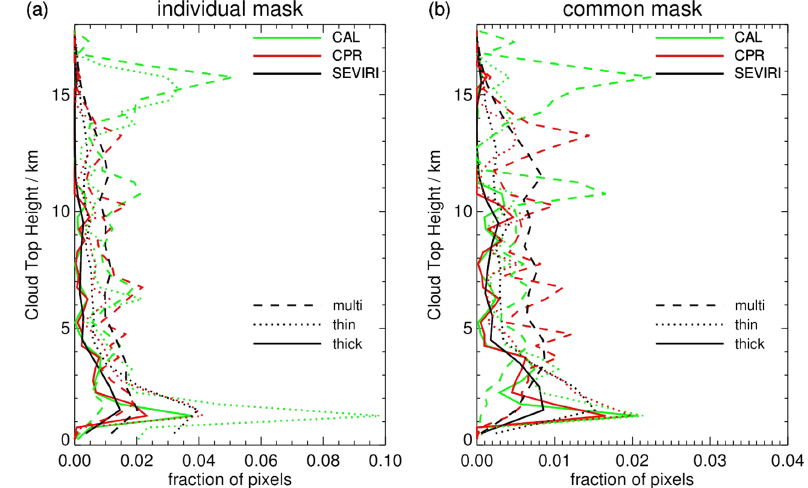
Figure 10. Histograms of the CTH of thick, thin and multi-layer clouds for 13 June 2008, 12:00–15:30UTC. Panel (a) shows the histograms of the data as provided by the original CALIOP and CPR data sets as well as the mean of the histograms of the unfiltered SEVIRI data sets. In panel (b) only satellite pixels are taken into account for which all data sets provide a value. For multi-layer cloud situations only the uppermost CTH is considered.